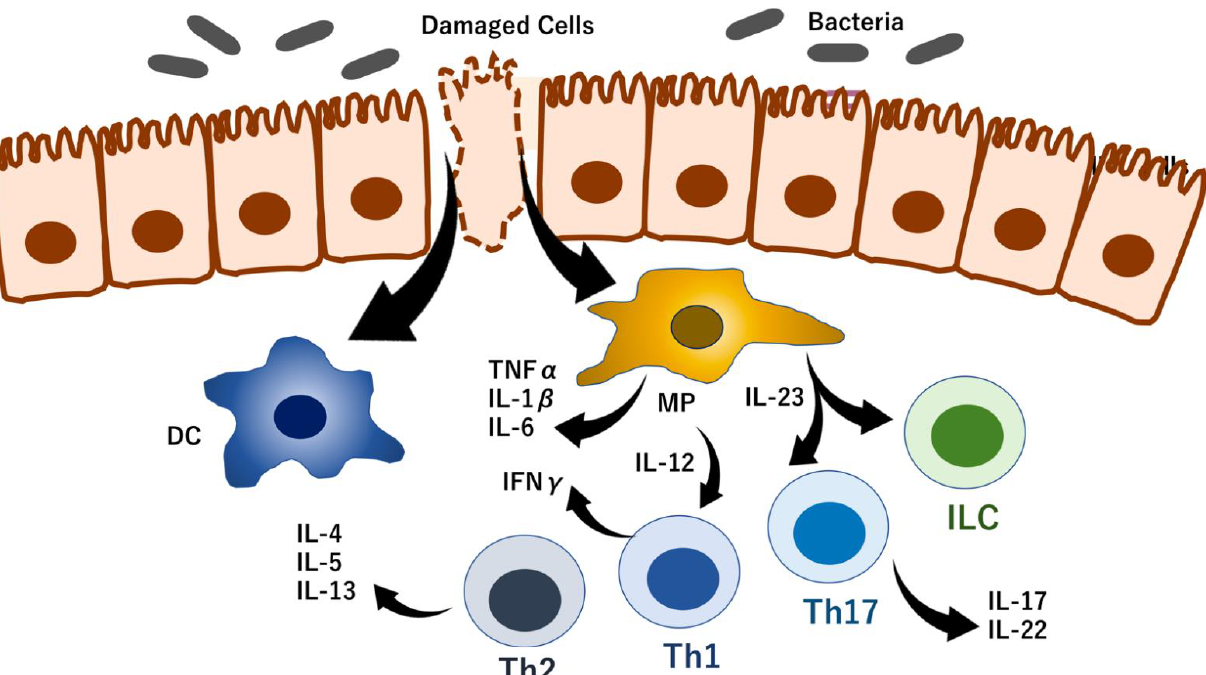
Figure 1. Overview of the mechanism of IBD. IBD is a complex disease that develops as result of multiple factors. Previous studies have revealed that genetic and epigenetic factors are involved in the maintenance of epithelial cell homeostasis in response to intestinal bacteria, food intake, and several irritants (e.g., cigarette smoking and alcohol intake), leading to epithelial cell damage and inflammation. Cell damage and infections stimulate dendritic cells (DC) and macrophages (MP) to secrete cytokines, including IL23, resulting in the activation of the immune response of innate lymphoid cells (ILC). The immune response can induce epithelial cell damage. In IBD, inhibition or modulation of the hyper reaction of immune cells or cytokines is a therapeutic target. In this review article, we focus RNA modification in IBD, as mentioned text, figures and tables.